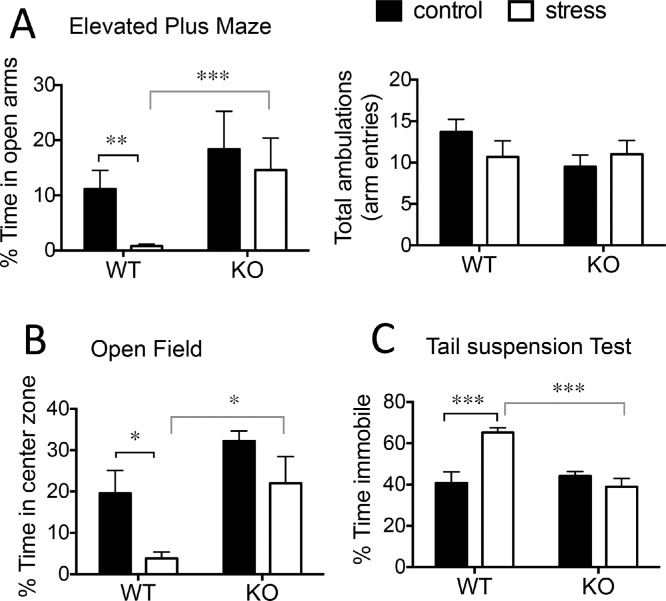
11β-HSD1 deficiency protect against effects of midlife chronic stress on affective behaviors in aged mice.Midlife stress increased anxiety [reduced time in open arms of EPM (A); decreased time in centre zone of open field (B)] and depressive-like behavior [increased immobility in tail suspension test (C)] in aged WT but not KO mice 6 months after stress cessation. Total ambulation (arm entries) in EPM, measured as an indicator of locomotor activity, did not differ between groups (A). Bonferroni post hoc tests, *p < 0.05, *** p < 0.001, n = 8–10/group. Data shown are mean ± SEM.